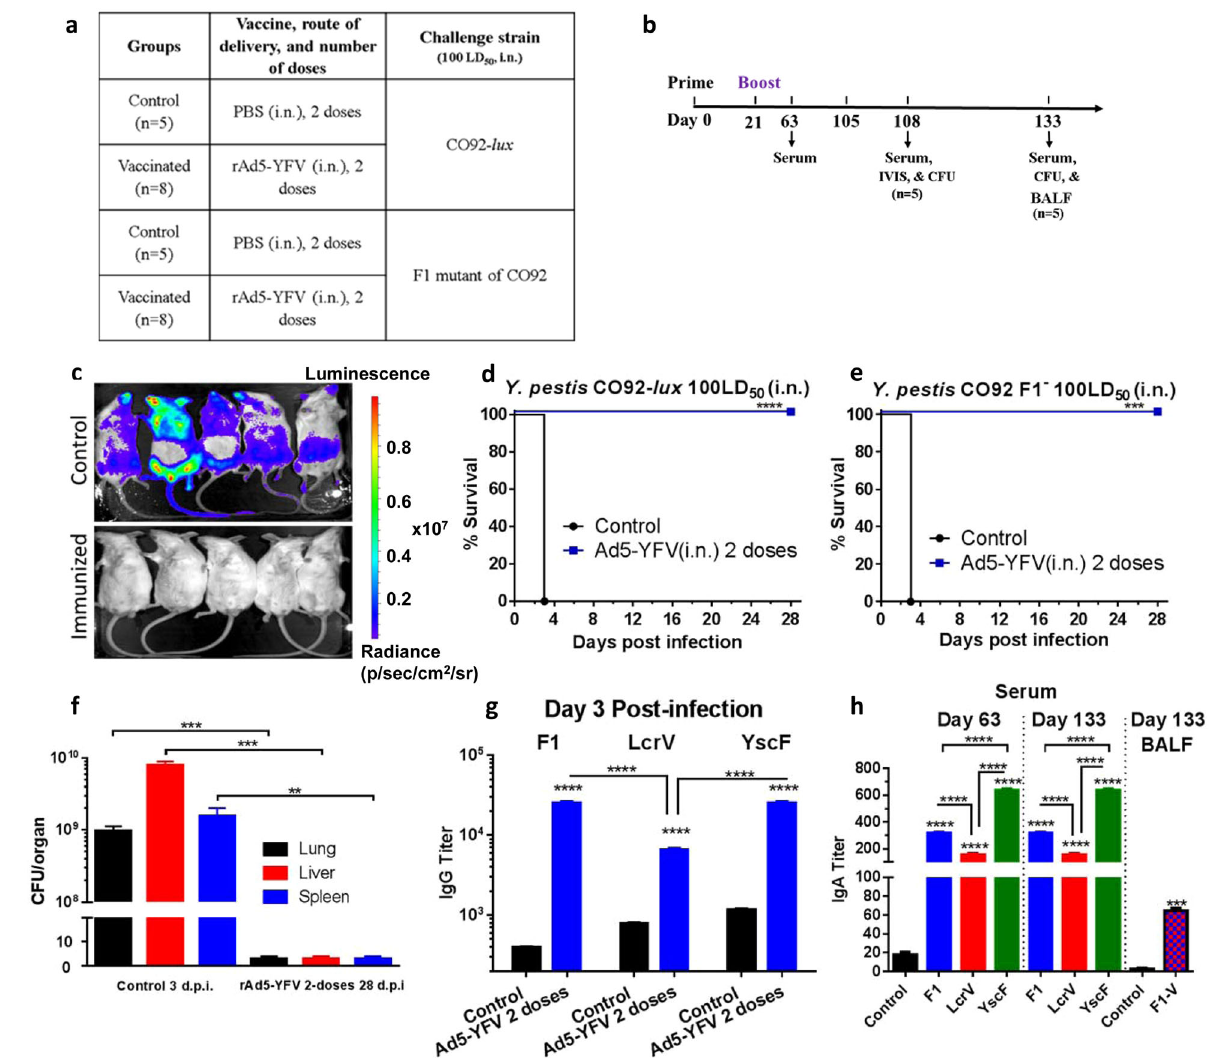
Fig. 5 Long-term protection and antibody titers in mice immunized with 2 doses of the rAd5-YFV vaccine. Mice ( n = 5 – 8/group) were immunized (i.n.) twice 21 days apart with 1.2×10 10 v.p. of the rAd5-YFV vaccine, with animals receiving PBS served as controls (Fig. 5a). Eighty- four days (day 105 of study) after last vaccination, mice were i.n. challenged with 100 LD 50 (5 × 10 4 CFU/40 µL) of Y. pestis CO92- lux or Y. pestis CO92 F1-minus strain (Fig. 5b). The progression of infection in Y. pestis CO92- lux challenged mice was monitored by IVIS, and representative images of mice with a heat map of bacterial burden from lowest (violet) to highest (red) at day 3 p.i. are shown (Fig. 5c). The percent of animal survival was plotted ( d ) for the Y. pestis CO92- lux challenge or ( e ) for its F1-minus strain challenge. The actual bacterial loads in moribund control mice at day 3 p.i., and in the rAd5-YFV immunized mice at day 28 p.i. is displayed in panel f . On day 3 p.i., serum was collected from each group, and F1, LcrV, and YscF speci fi c IgG titers were determined by ELISA ( g ). On days 63, and 133 (Fig. 5b), serum was examined for